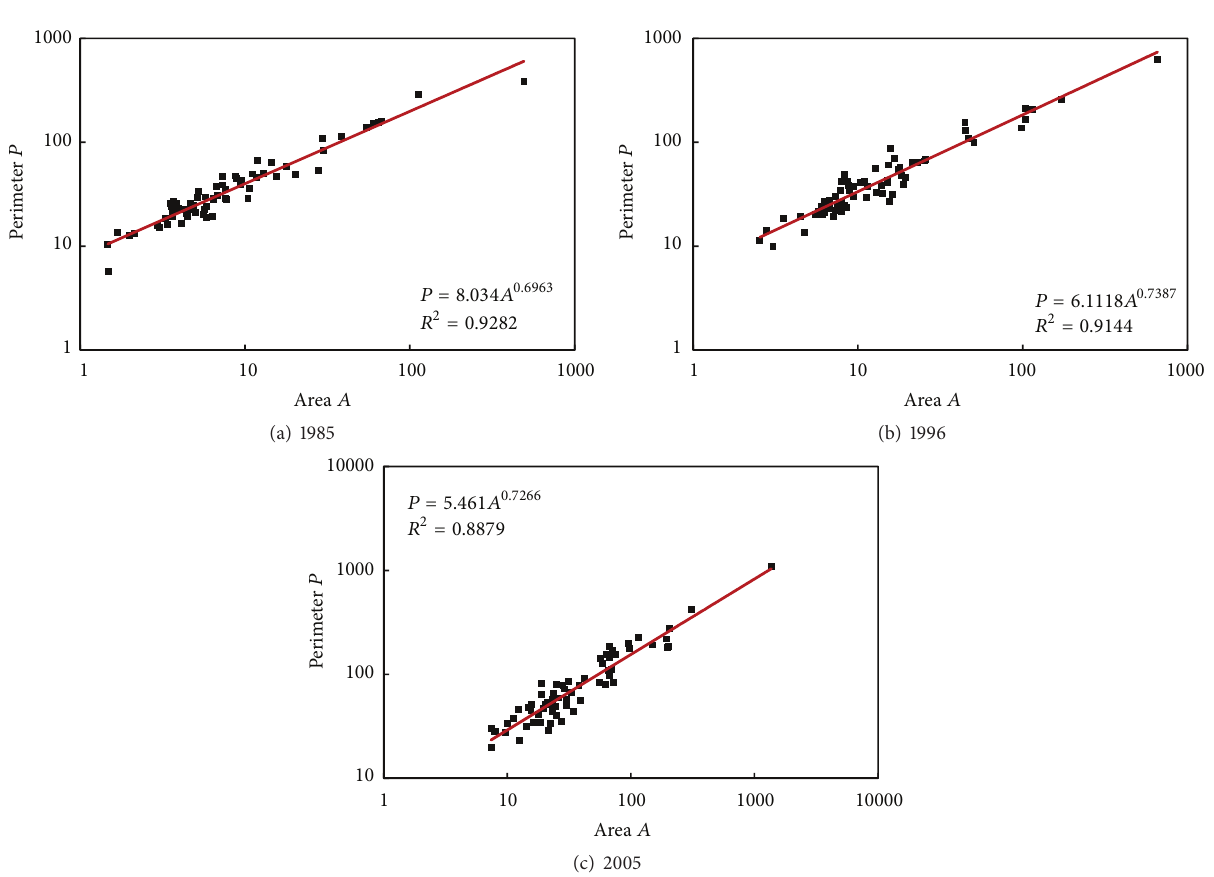
and the average value is often near 1.25 [20, 30, 48]. The other is the regression method. By the least squares calculation of cross-sectional datasets, we can estimate the 𝑘 values using (9). This is an unfixed parameter: the 𝑘 value changes over time (Table 2). Using the variable 𝑘 value to replace the fixed 𝑘 value in (3), we can estimate the boundary dimension 𝐷